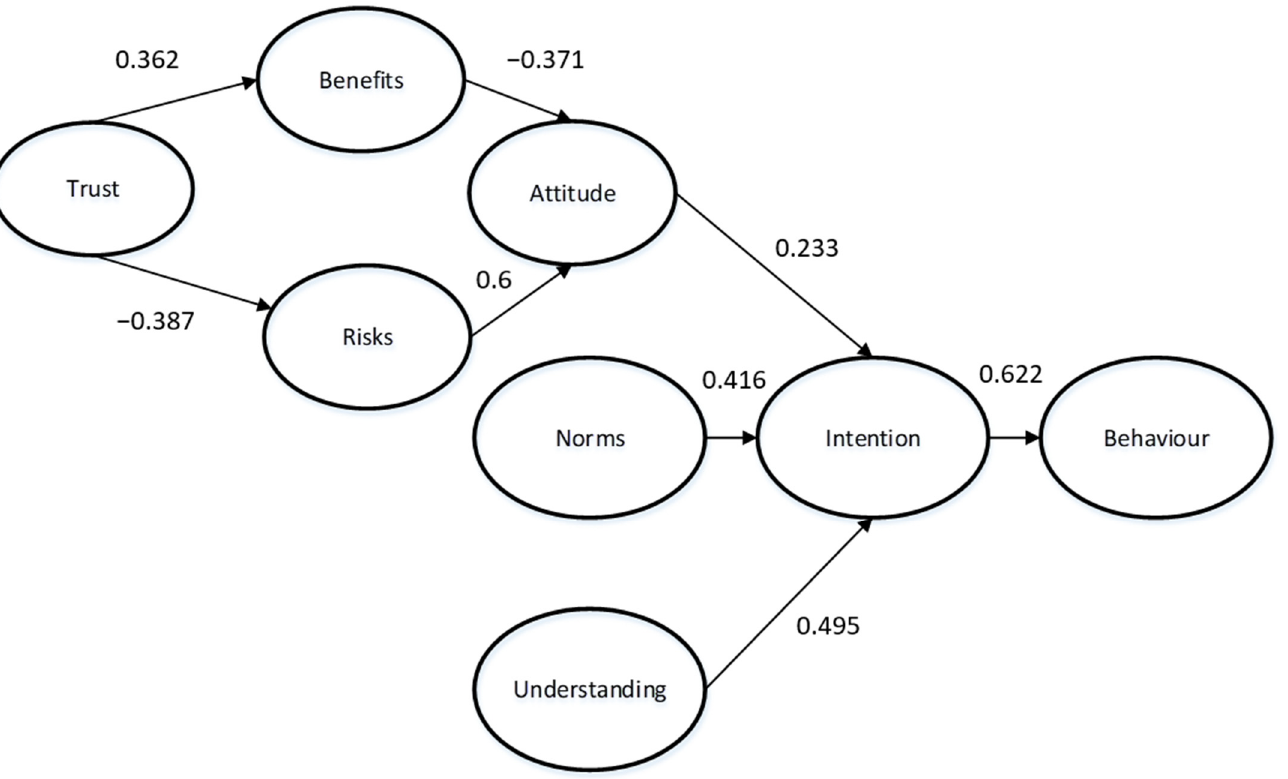
Figure 2. Path coefficients of the research model.